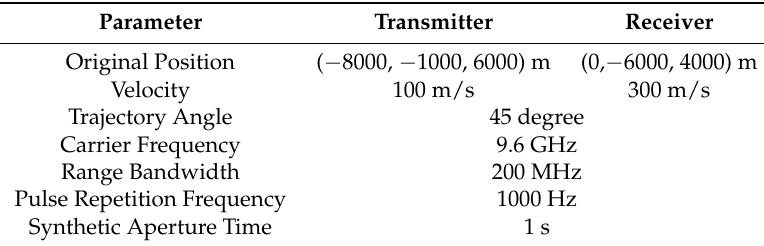
Table 1. Simulation